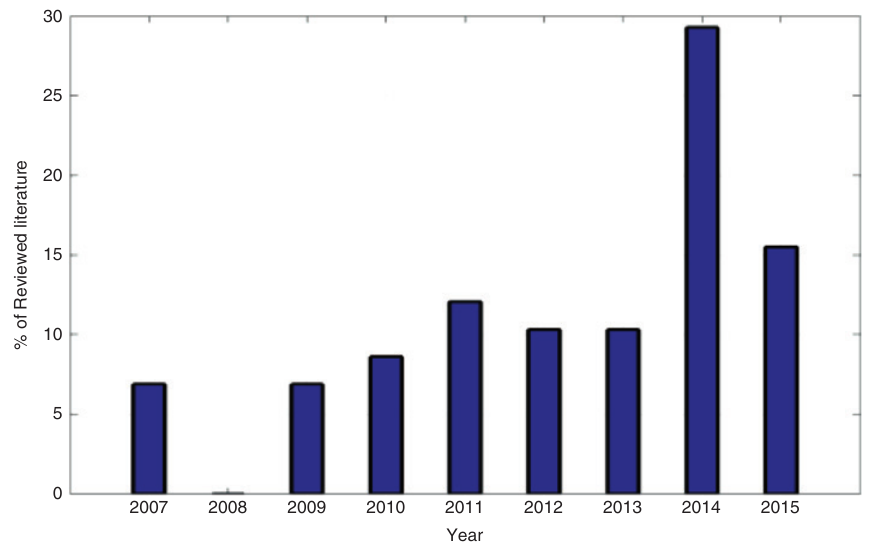
Figure 1: Statistical Report of Research